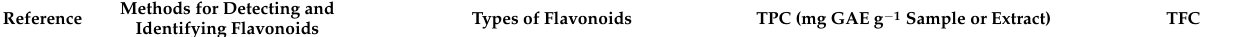
Table 2. Detection and identification of flavonoids in the leaves of E. guineensis and their TPC and TFC values. Reference Methods for Detecting and Identifying